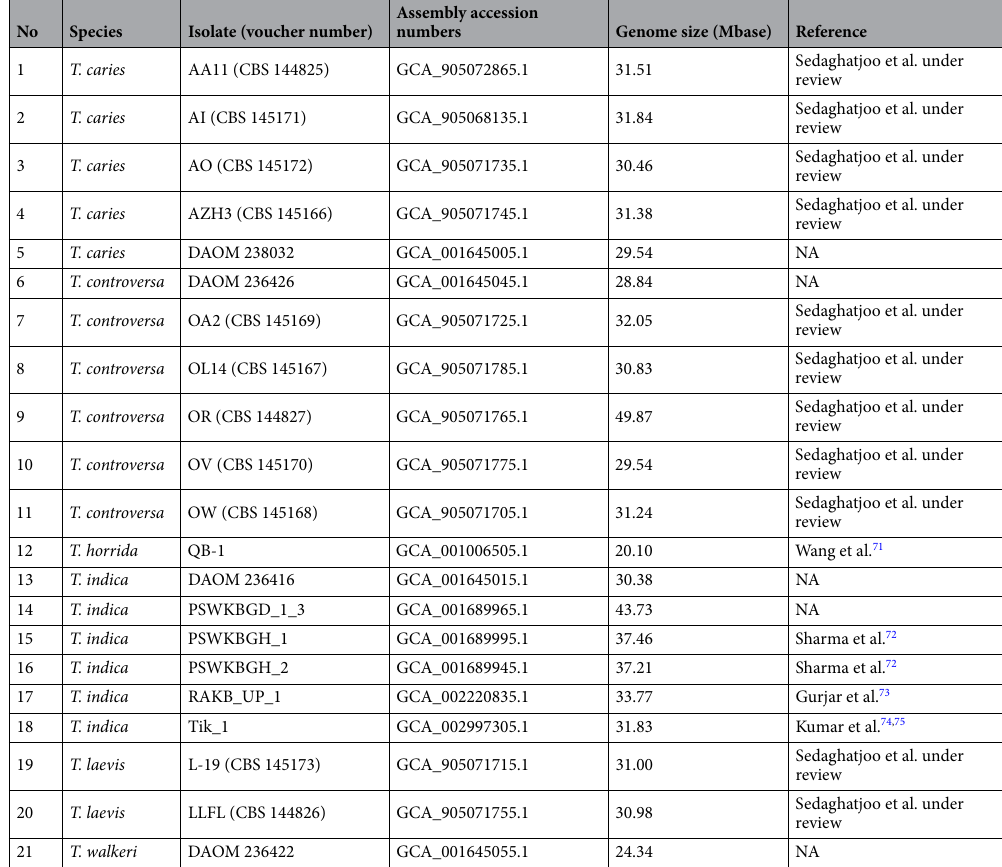
Table 3. Genome sequences used in this study and their accession